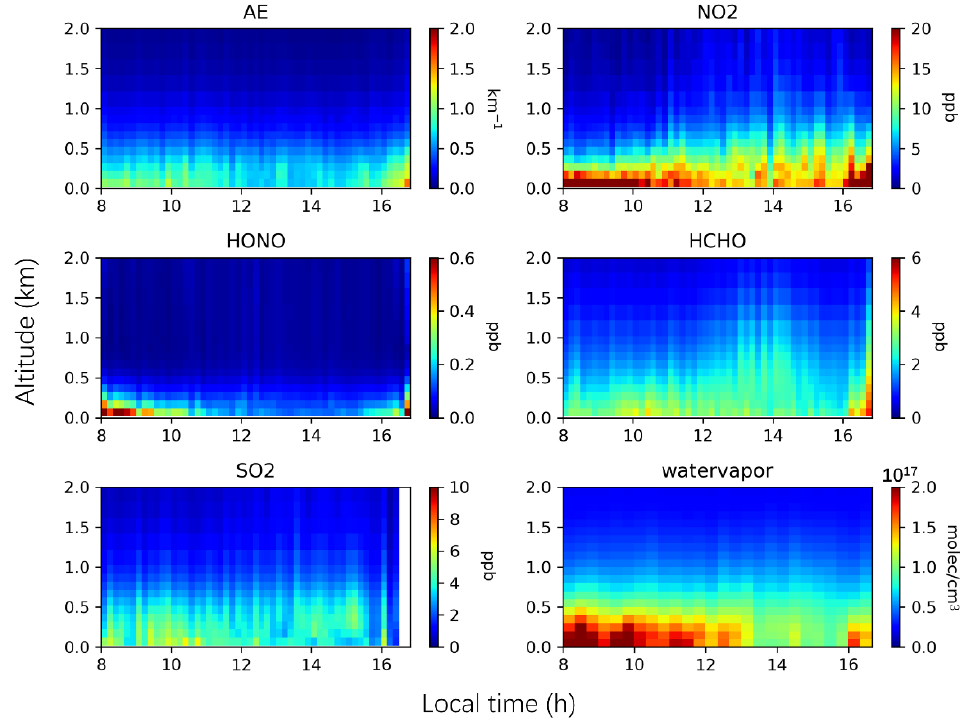
Figure 4. Diurnal variations of the vertical distribution characters of tropospheric aerosol extinction coefficient, and HONO, SO 2 , NO 2 , HCHO, and water vapor vertical mixing ratios during the whole campaign.